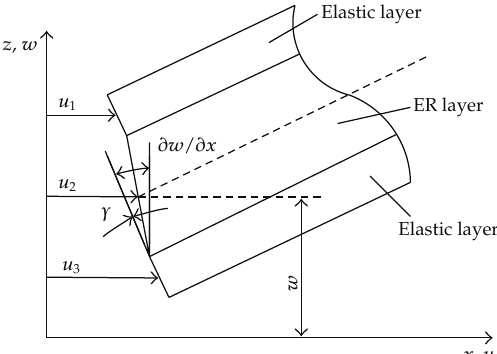
Figure 3: Kinematic relationships of deflected